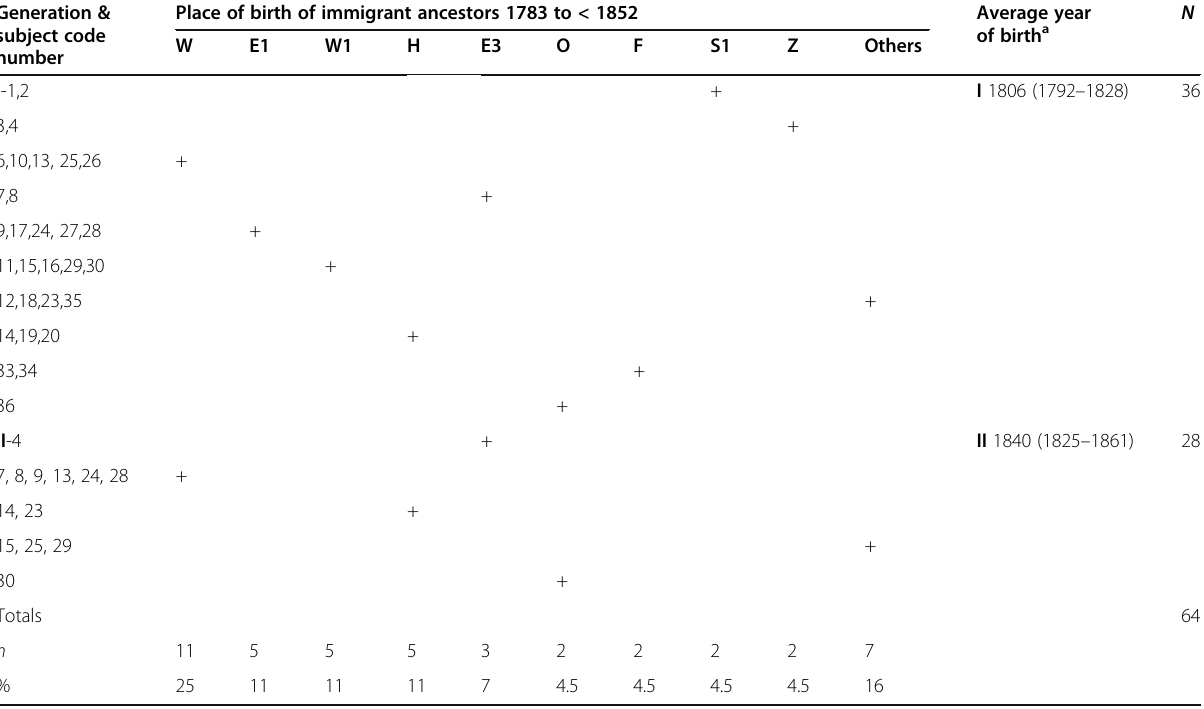
Bold = outside of Württemberg state. Cursive = outside the Württemberg focus III quadrant in Fig. 2. W = Wyhl, E1 = Endingen, W1 = Wasenweiler, H = Herbolzheim, E3 = Erfurtshausen, O = Oberbergen, F = Forchheim, S1 = Schweich, Z = Zierenberg, Others = Gräfenhausen , Ringsheim, Oberalpfen, Hugstetten,